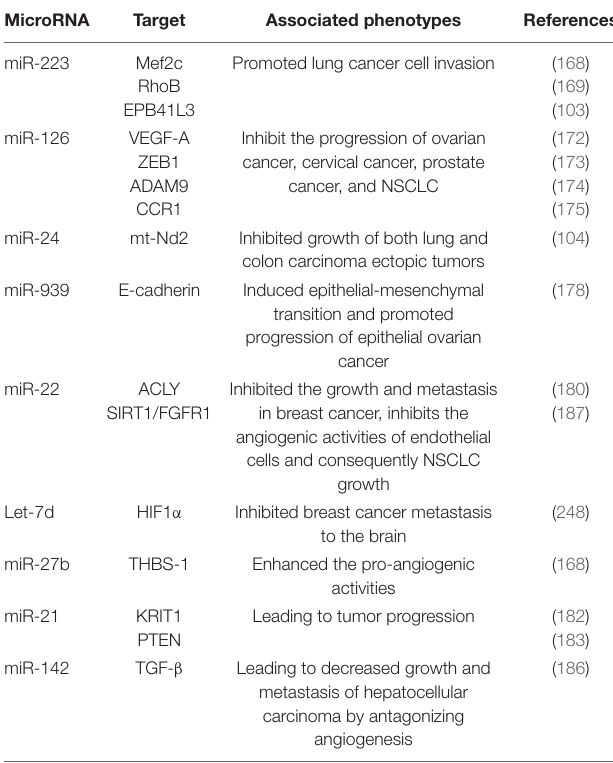
TABLE 4 | The potential roles of platelet miRNAs on